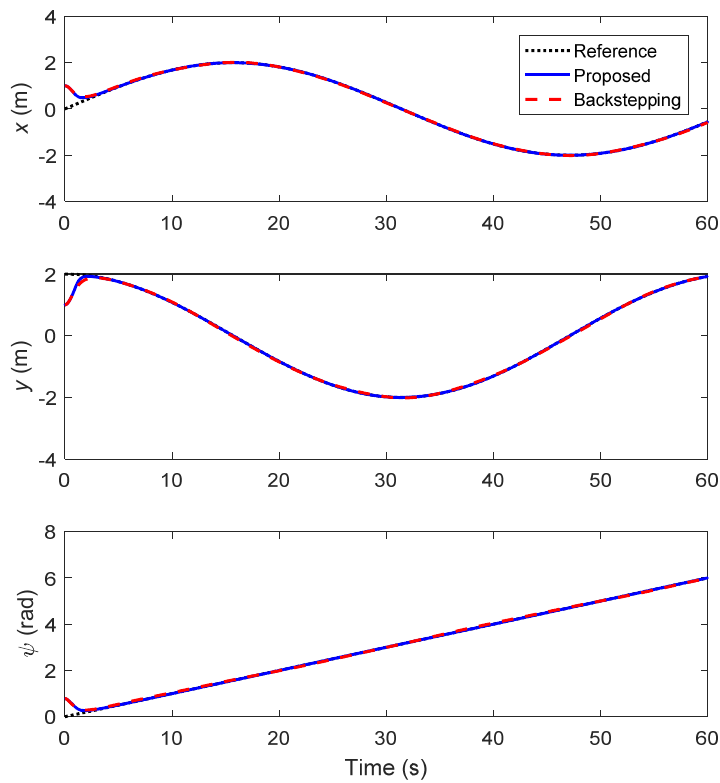
Figure 4. Pro fi le of the position tracking (Case 1).